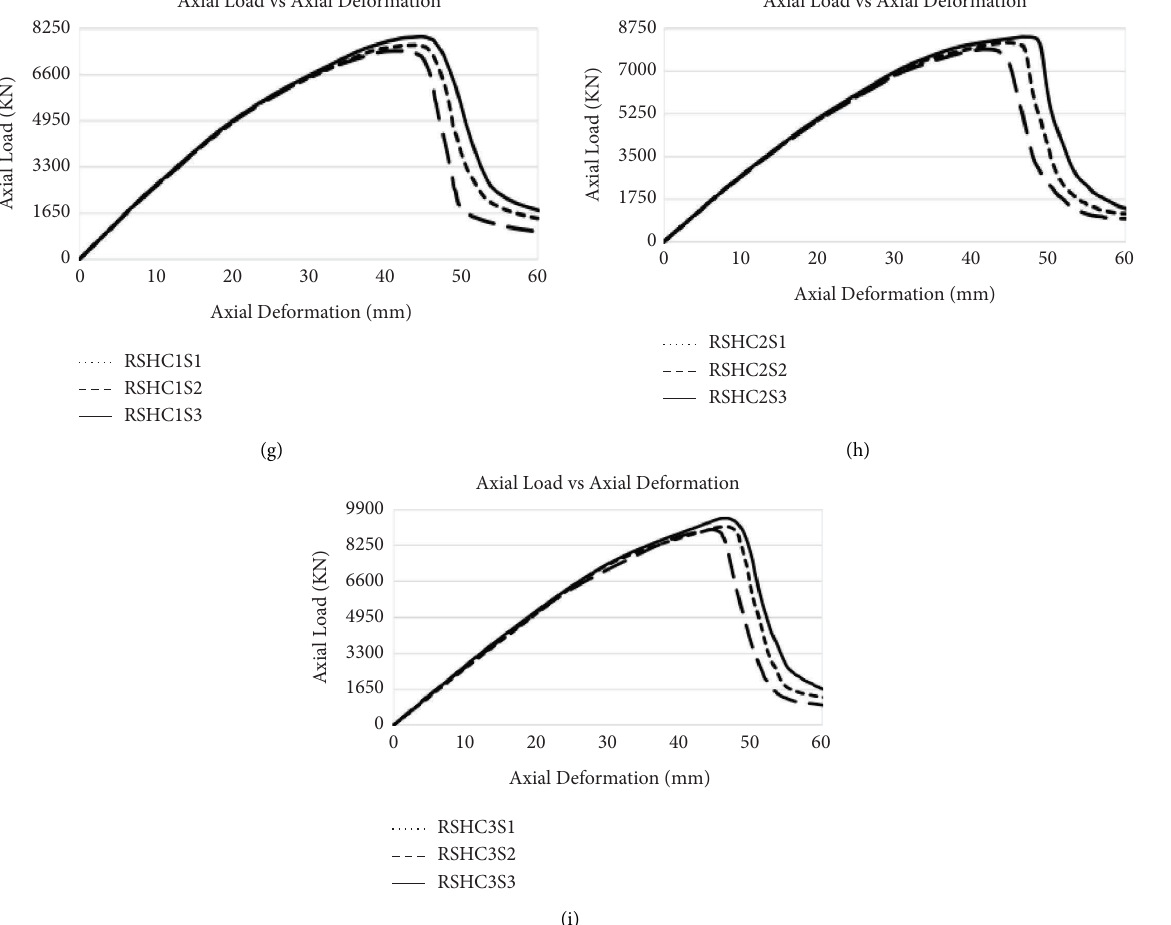
Figure 10: Efect of tie bar spacing on axial load versus axial deformation response of FECC-C (a–c), FECC-I (d–f), and FECC-R (g–i) slender columns.